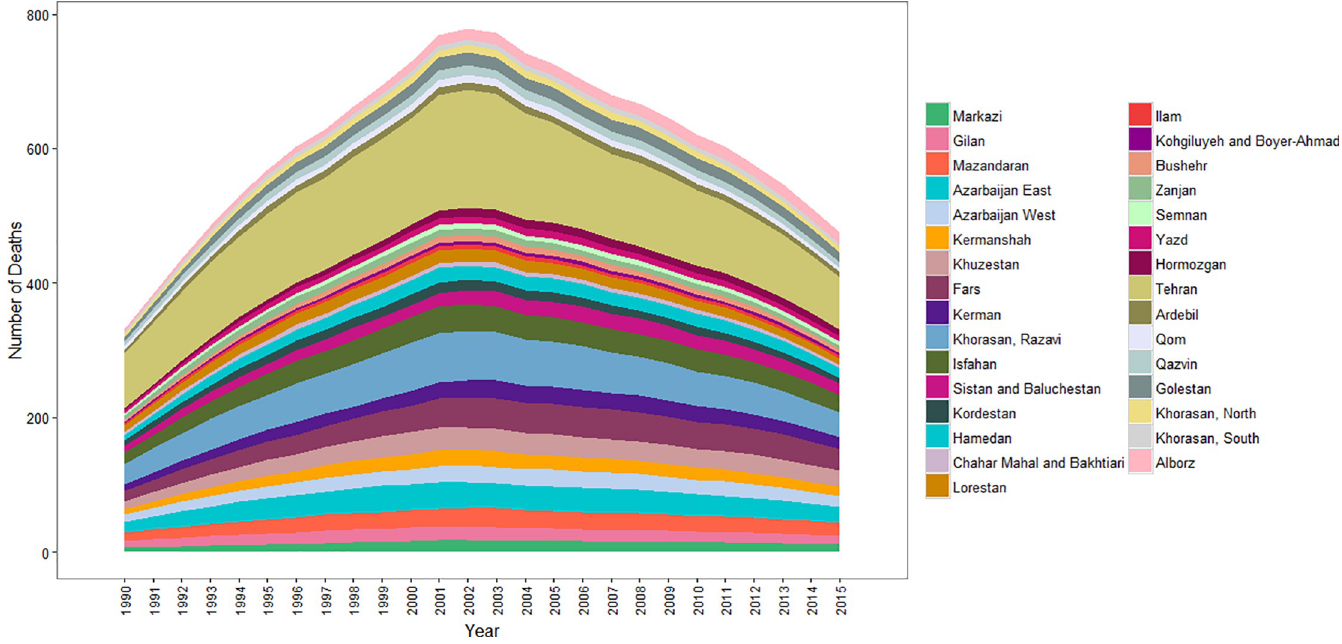
Fig 1. Liver cirrhosis absolute number of deaths from 1990 to 2015 by province in Iran.